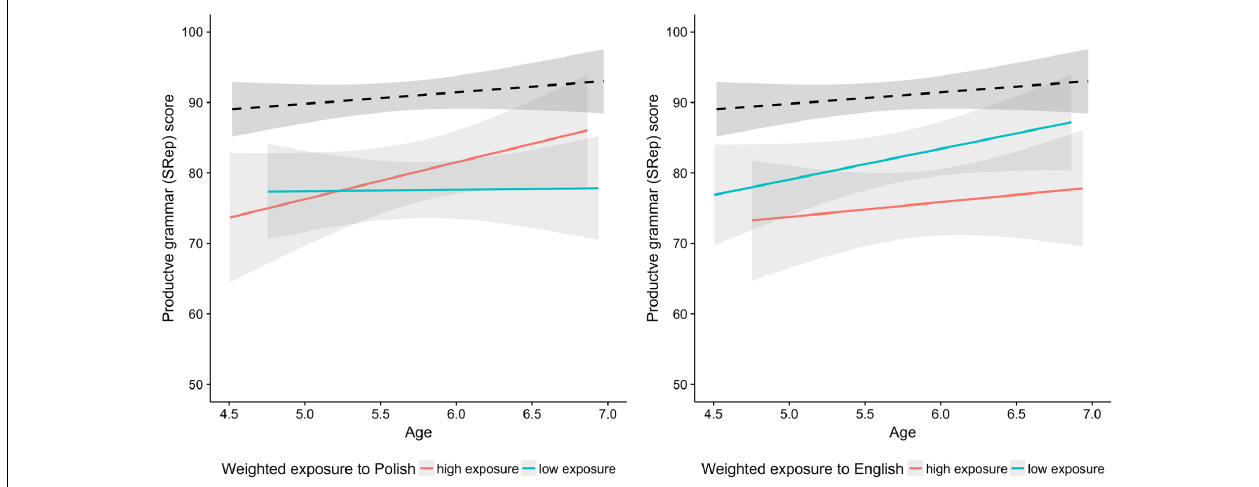
FIGURE 6 | Scores in the productive grammar test plotted as a function of age. Black dashed line indicates the monolingual group and the two colored lines correspond to the bilingual group. The data for bilinguals is broken down by the median split amount of weighted exposure to Polish and English. Red and aqua correspond to the median split on exposure to L1 Polish (left side) and to L2 English (right side). The median split was performed for visualization purpose only.